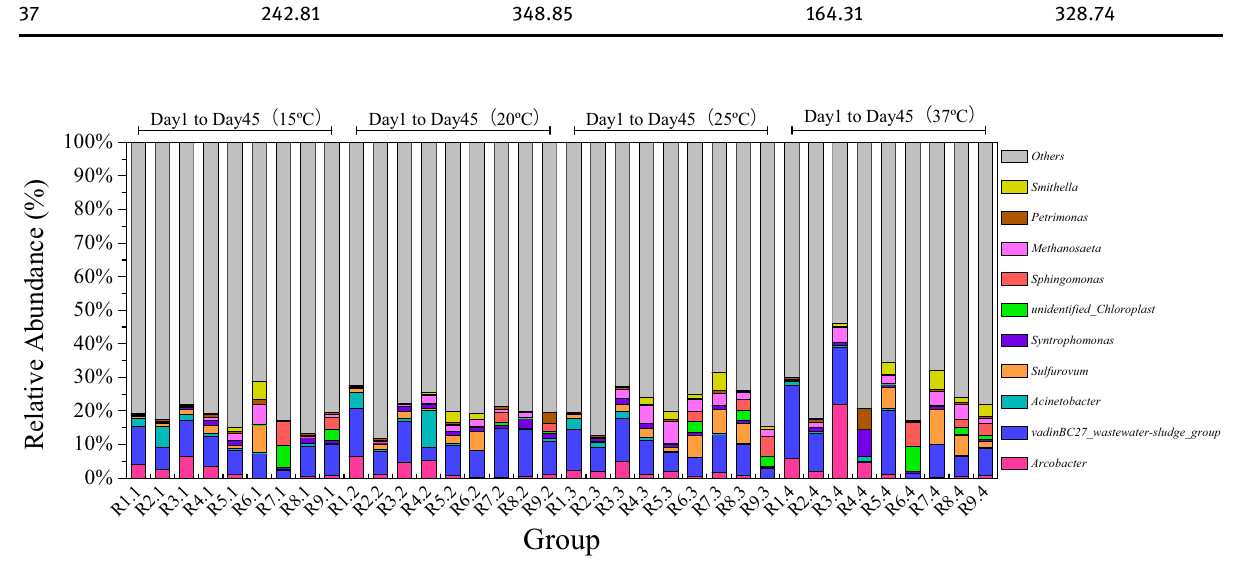
Figure A1: Relative abundance changes of the microbial community at the genus level in the anaerobic digestion of cattle manure at medium to low temperatures.